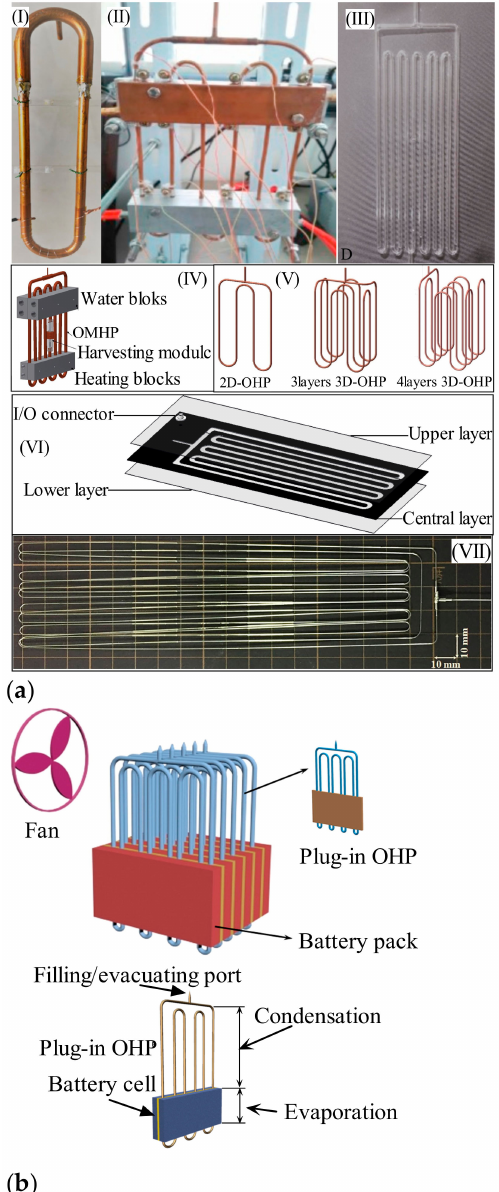
Figure 3. OHP array and distribution structure for cooling. ( a ) Multi-loop OHP array and distribution structure for spacecraft cooling; ( b ) OHP distribution for battery cooling. (I) Qian et al., (2019), [56]. (II) Zhao et al., (2016), [58]. (III). Jin et al., (2019), [60]. (IV). Monroe et al., (2018), [57]. (V). Qu et al., (2019), [59]. (VI). Alqahtani et al., (2022), [61]. (VII). Iwata et al., (2021),